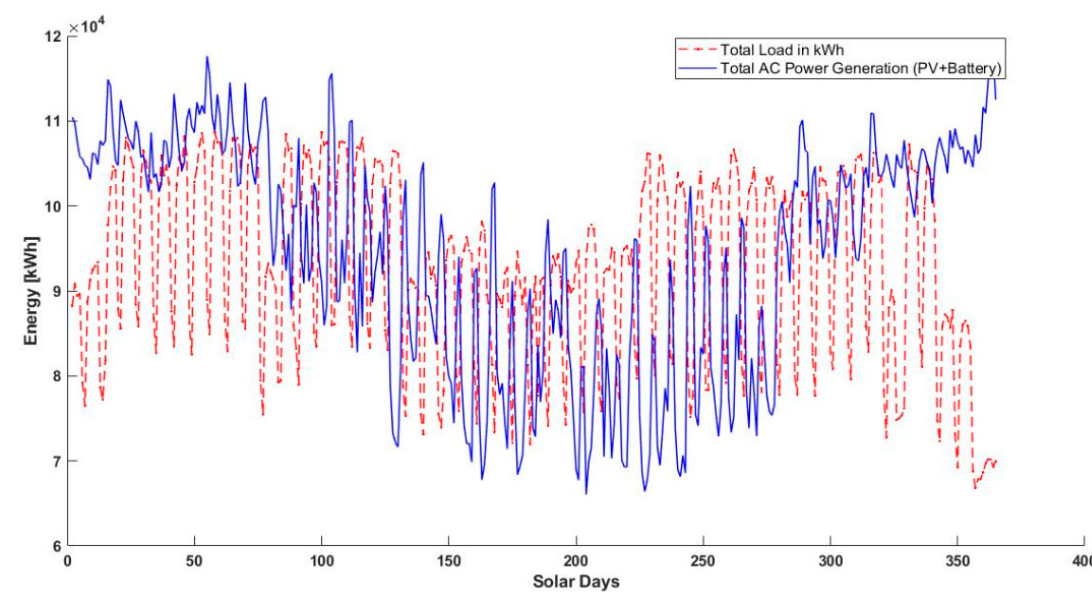
Figure 11. Total load requirement vs. total power generated by the PV and battery system. The power deficit is covered by purchasing power from the utility grid.